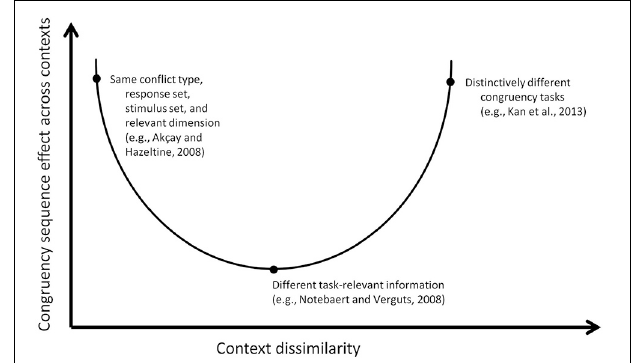
FIGURE 1 | Abstract depiction of the hypothesized u-shaped relation between context (dis)similarity and congruency sequence effects across contexts. As per example, three different empirical studies are displayed along the